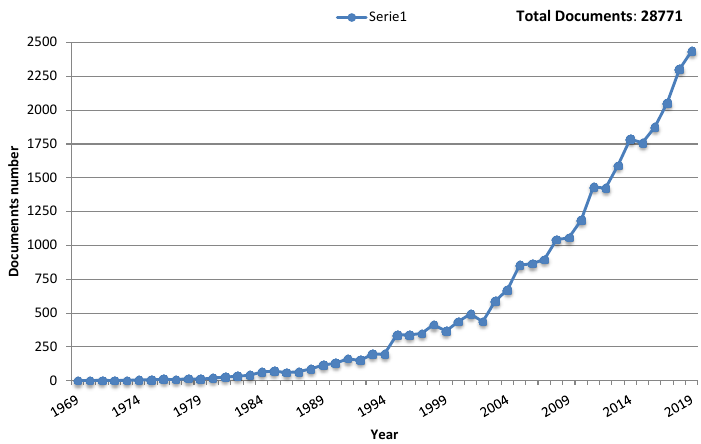
Figure 2. Number of publications per year with titles, abstract or keywords including the terms “gas sensor” (Source: Scopus [2]).